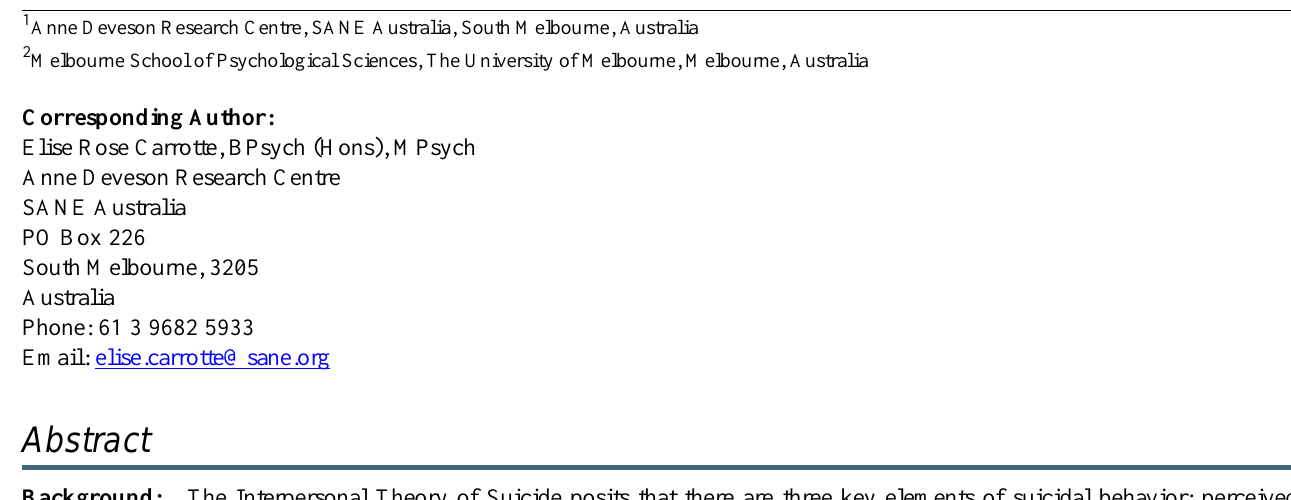
suicide; interpersonal theory of suicide; social media; co-design; lived